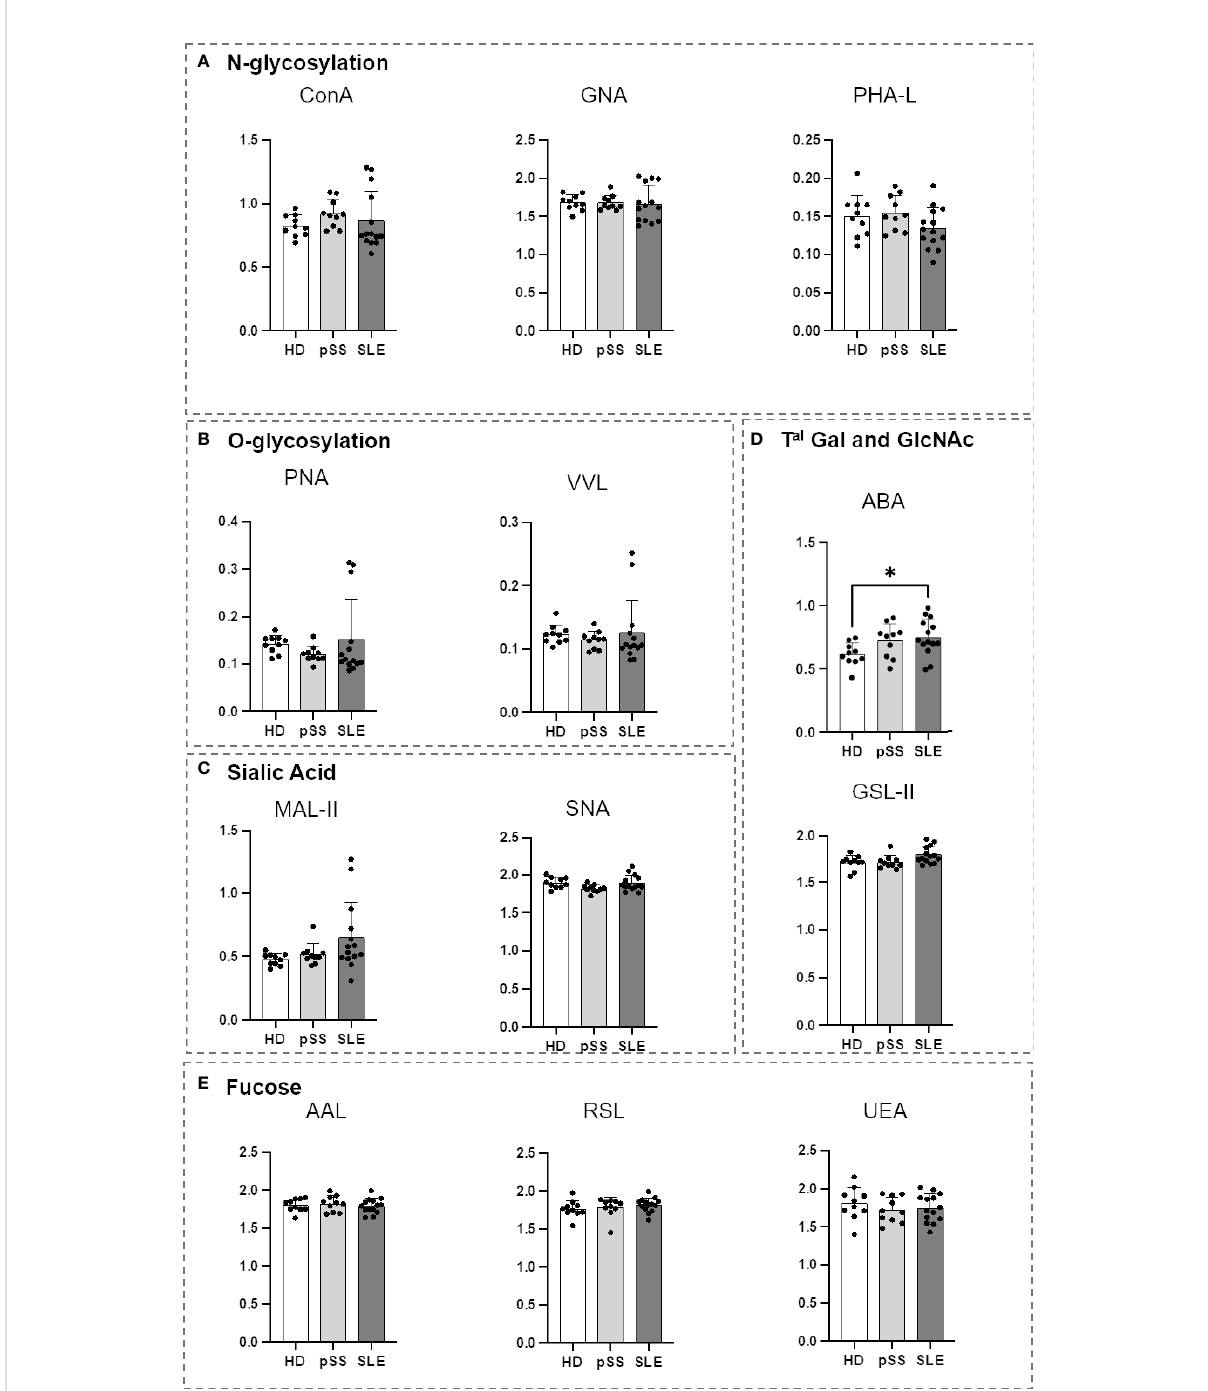
FIGURE 6 Comparison of serum protein N- and O-glycosylation from systemic lupus erythematosus (SLE), primary Sjögren ’ s syndrome (pSS) and healthy donors (HD). First, the serum protein concentration from healthy donors (HD), primary Sjögren ’ s syndrome (pSS) and systemic lupus erythematosus (SLE) patients (10 for each) was quanti fi ed using the bicinchoninic acid assay test. The equivalent of 7 µg of serum protein was used from each patient, diluted in PBS and coated in MaxiSorp 96-well Nunc plates for 2 h at room temperature (RT). After 5 washes with PBS supplemented with 0,05% Tween 20, biotinylated lectins (Table 2) were added at optimized concentration for 1 h at RT. After 5 wash steps streptavidin-Horse Radish Peroxydase (HRP) was added for 30 min at RT. After 5 wash steps, Tetramethylbenzidine (TMB) was added was added for 8 min and the reaction was stopped with sulfuric acid. The optical density (OD) at 450 nm was determined for each lectin. Results are presented as followed: N-glycosylation in (A) , O-glycosylation in (B) , Sialylation in (C) , Terminal (T al ) Gal and GlcNAc on N and O-glycosylation in (D) , Fucosylation in (E) . One-way anova test followed by Dunn ’ s multiple comparison test were performed. ns, not signi fi cant p > 0,05, stars are indicated when p< 0,05